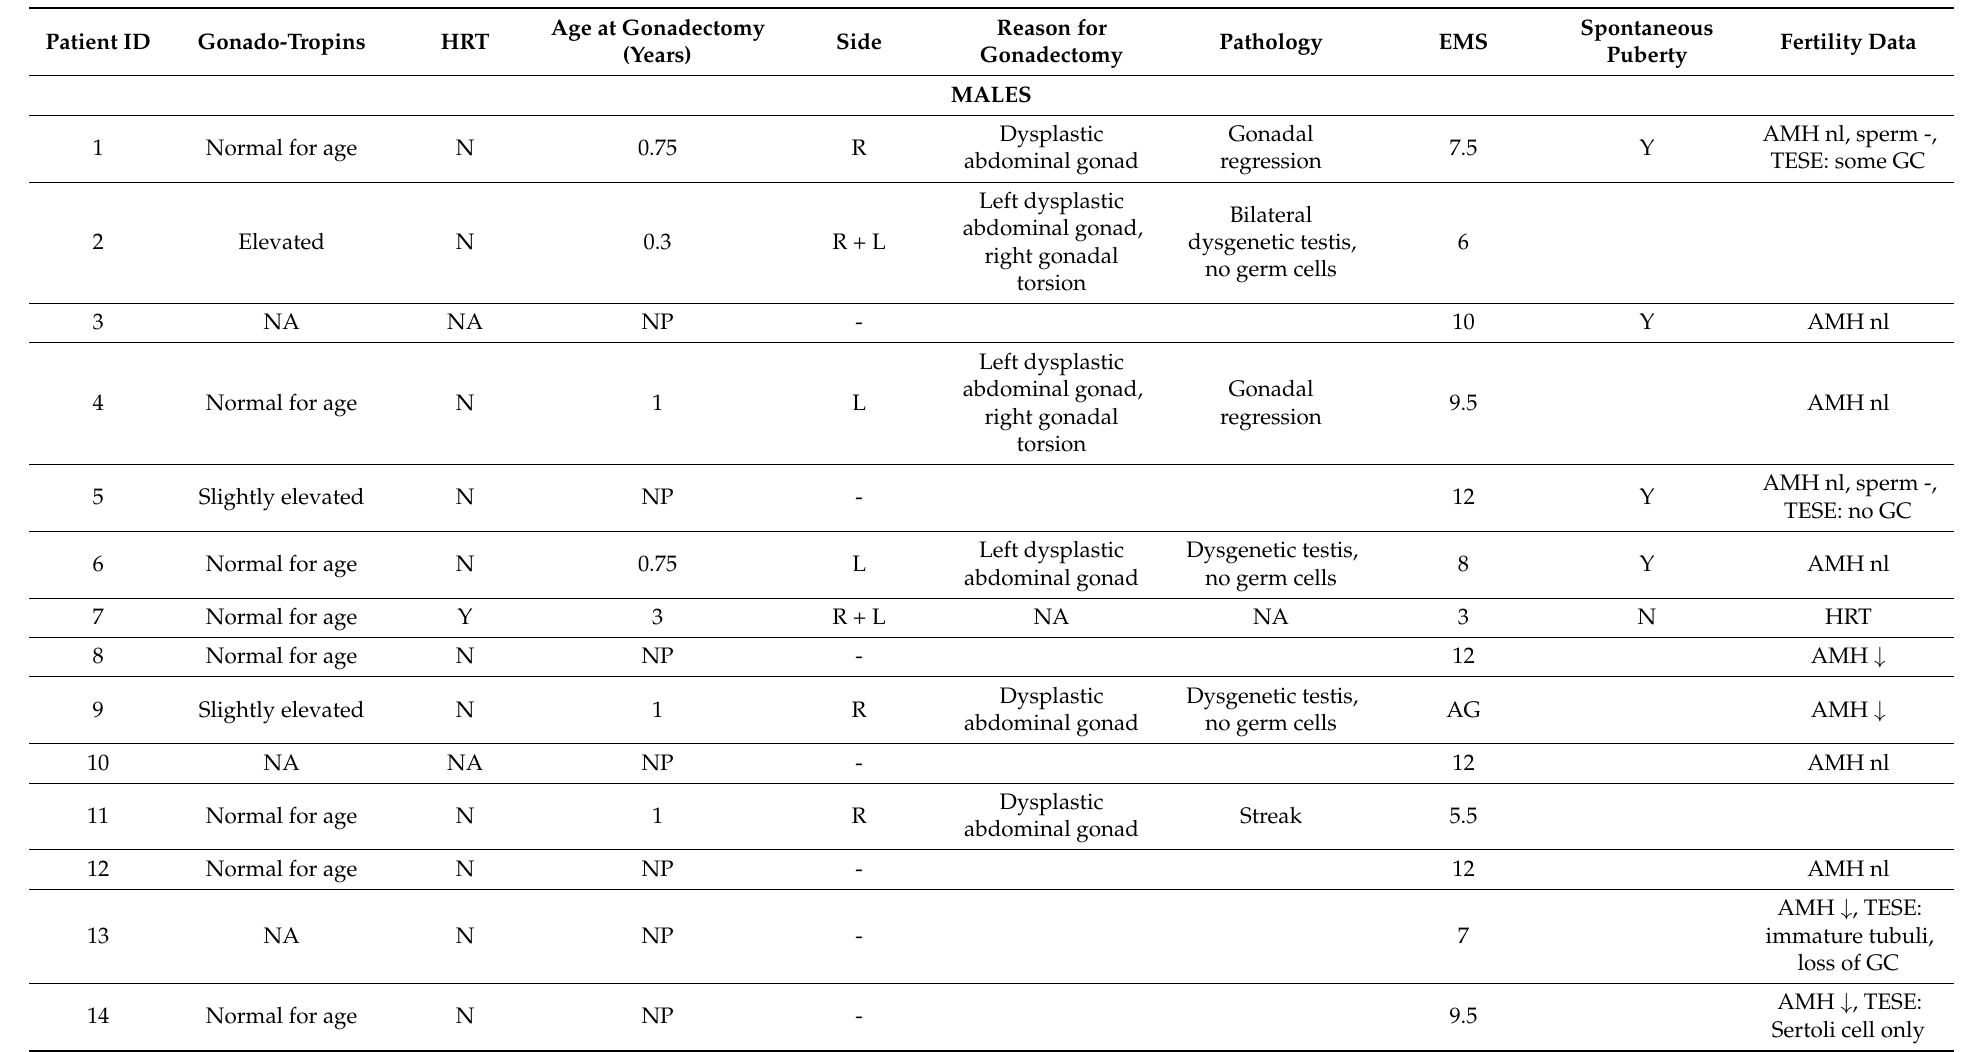
Table 4. Gonadal function and